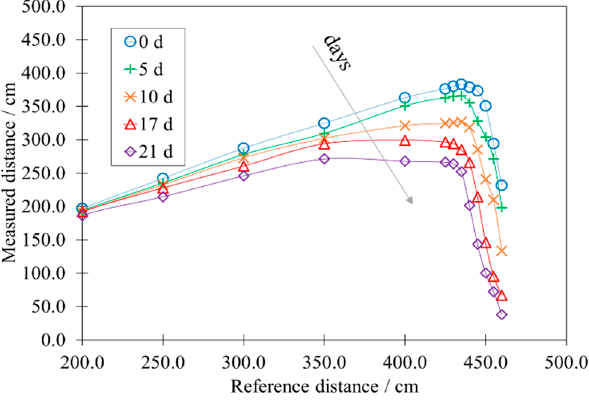
Figure 8. Influence of the accelerated aging on the calibration curve of the HY-SRF05.